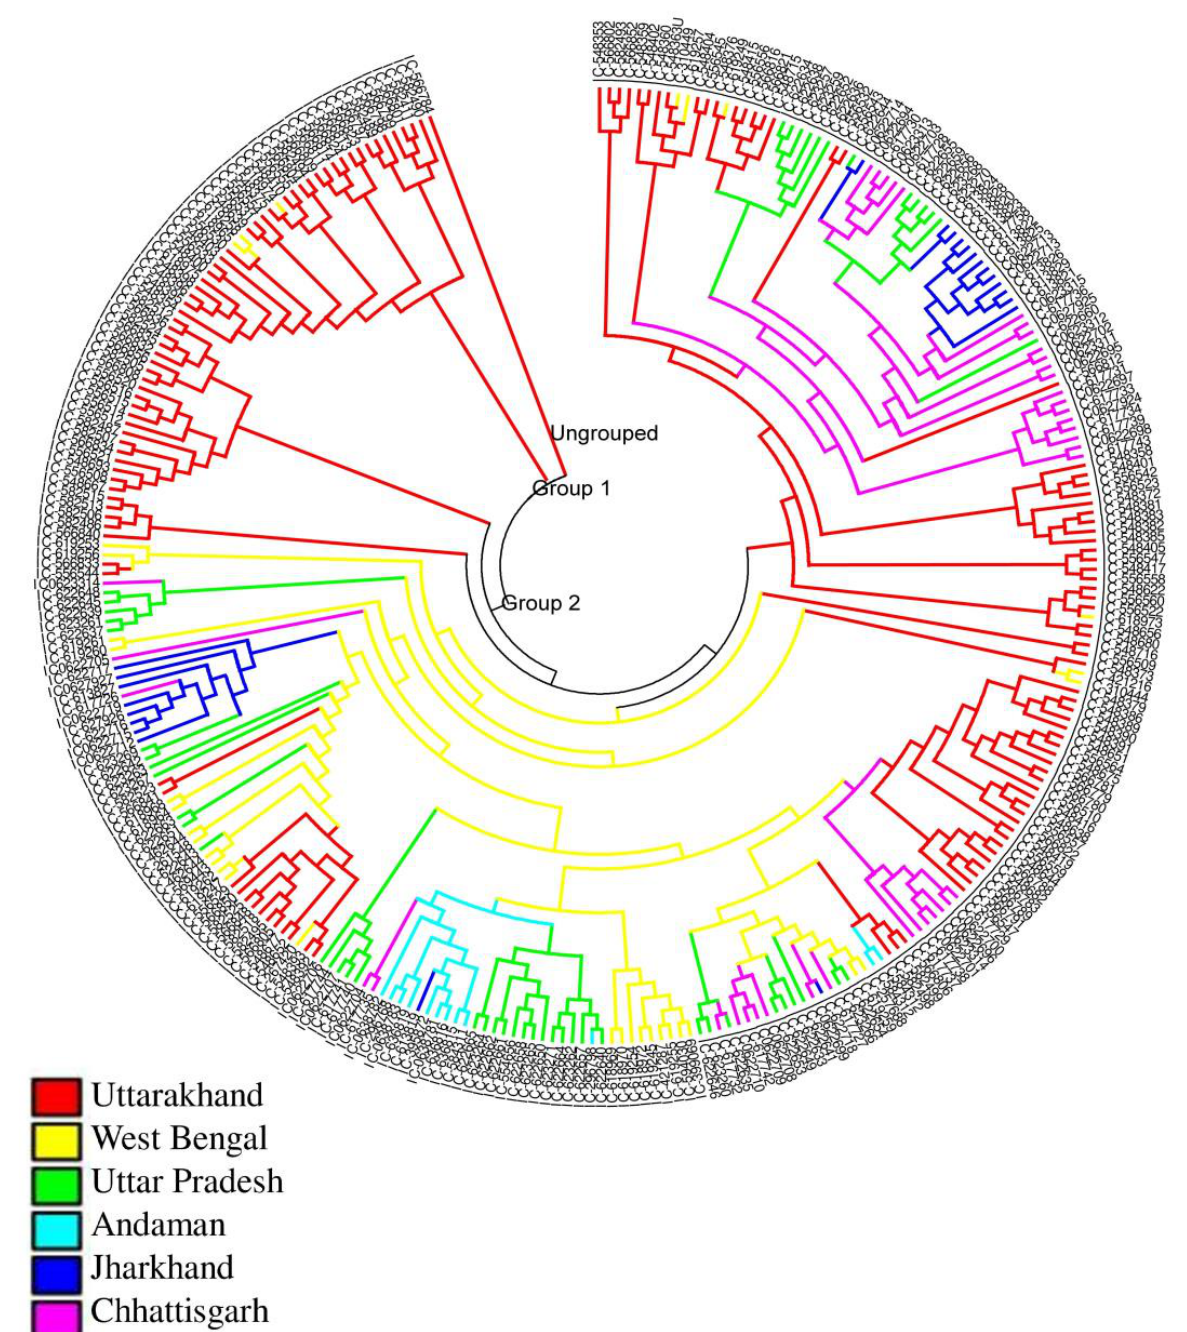
Figure 3. Neighbor-joining tree of 298 rice landraces using SNP markers.